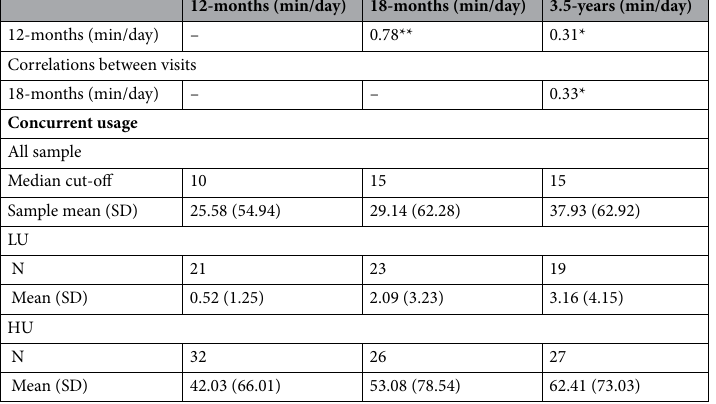
Table 3. Parent-reported touchscreen use (minutes/day) details for the TABLET sample and concurrent usage groups (LU = low user, HU = high user) split by visit. *p < .05, **p < .001 for the Spearman’s rho